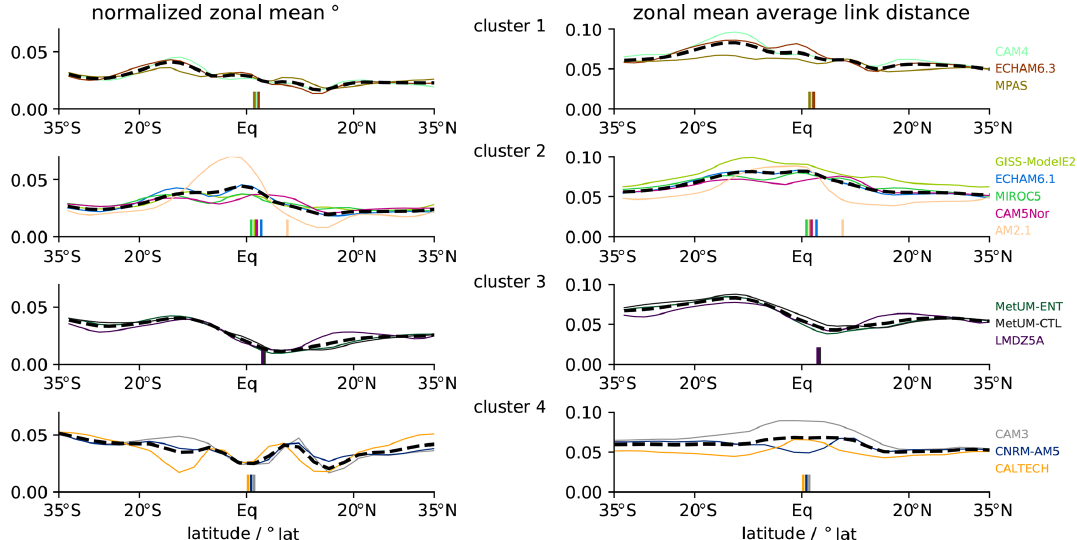
Figure 7. Zonal-mean network characteristics for the AquaControl simulations without extratropical–extratropical connections for each of the four clusters of models. The left panels show the normalized zonal-mean degree, while the right panels display the corresponding average link distances. Vertical lines indicate the respective position of the ITCZ. The cluster means are shown by black dashed